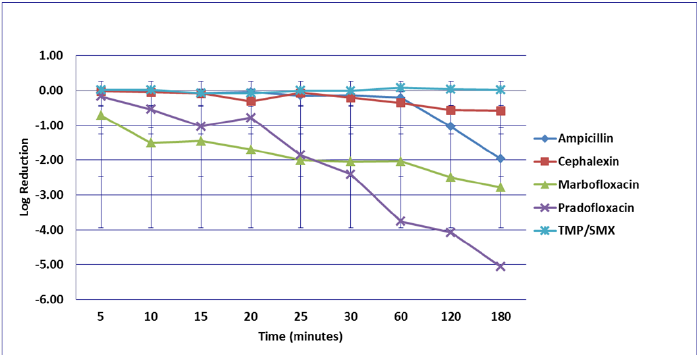
Figure 2. Log 10 reduction in E. coli with bacterial cells exposed to ampicillin, marbofloxacin, and pradofloxacin at the mutant prevention drug concentration. Marbofloxacin versus ampicillin at 30 min p = 0.0289. Data points present mean ± standard deviation.